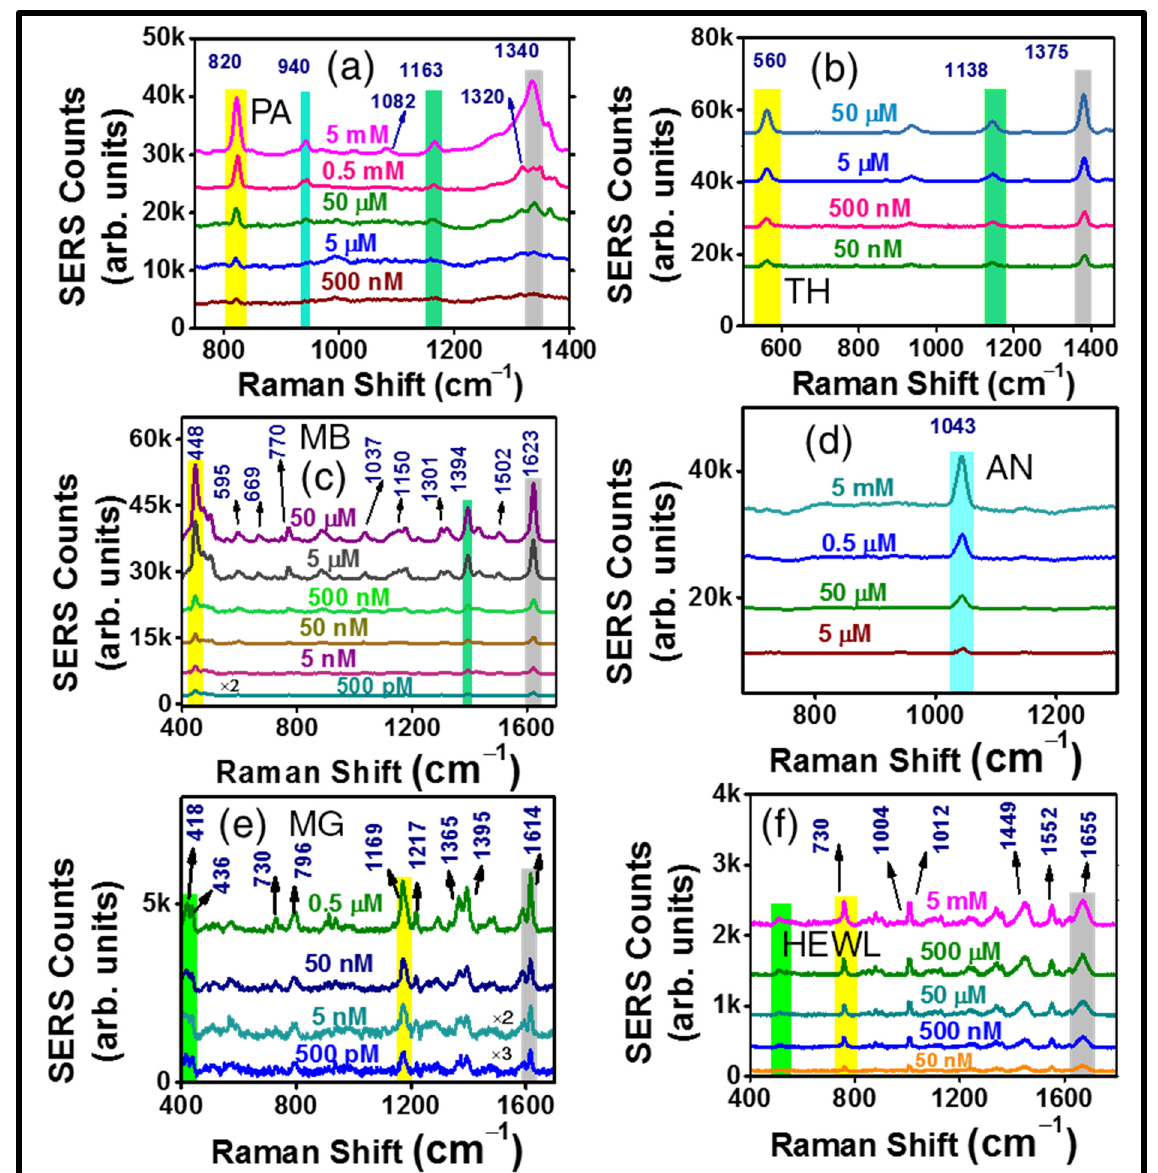
Figure 5. SERS data obtained with six different molecules using portable Raman as well as micro- Raman instrument. Portable Raman spectra were collected with 785 nm, 102 mW (30% of full power) excitation power, 5 s of accumulation time, number of spectral averaging 3, and the laser spot size ~100 μ m. Figures demonstrate the concentration dependent Raman spectra for ( a ) PA (500 nM), ( b ) TH (50 nM), ( c ) MB (500 pM), ( d ) AN (5 μ M), ( e ) MG (500 pM) molecules, also with their lowest traces. Similarly, figure ( f ) depicts about the concentration varied SERS spectra of HEWL (lysozyme protein biomolecule) collected with 25% of the full power (540 mW) of a 532 nm excitation laser engaged micro-Raman, using an acquisition time of 5 s, accumulation number of 3.